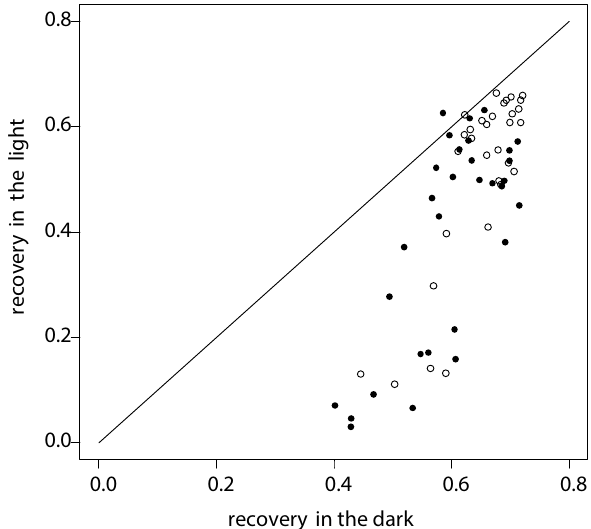
Figure 2. Comparison of FT of attached leaves as assessed with chlorophyll fluorescence subsequent to a freezing test after 24 h recovery in complete darkness vs. recovery in a day/night light regime for freezing test performed at − 13 °C (E1 open circles and E2 closed